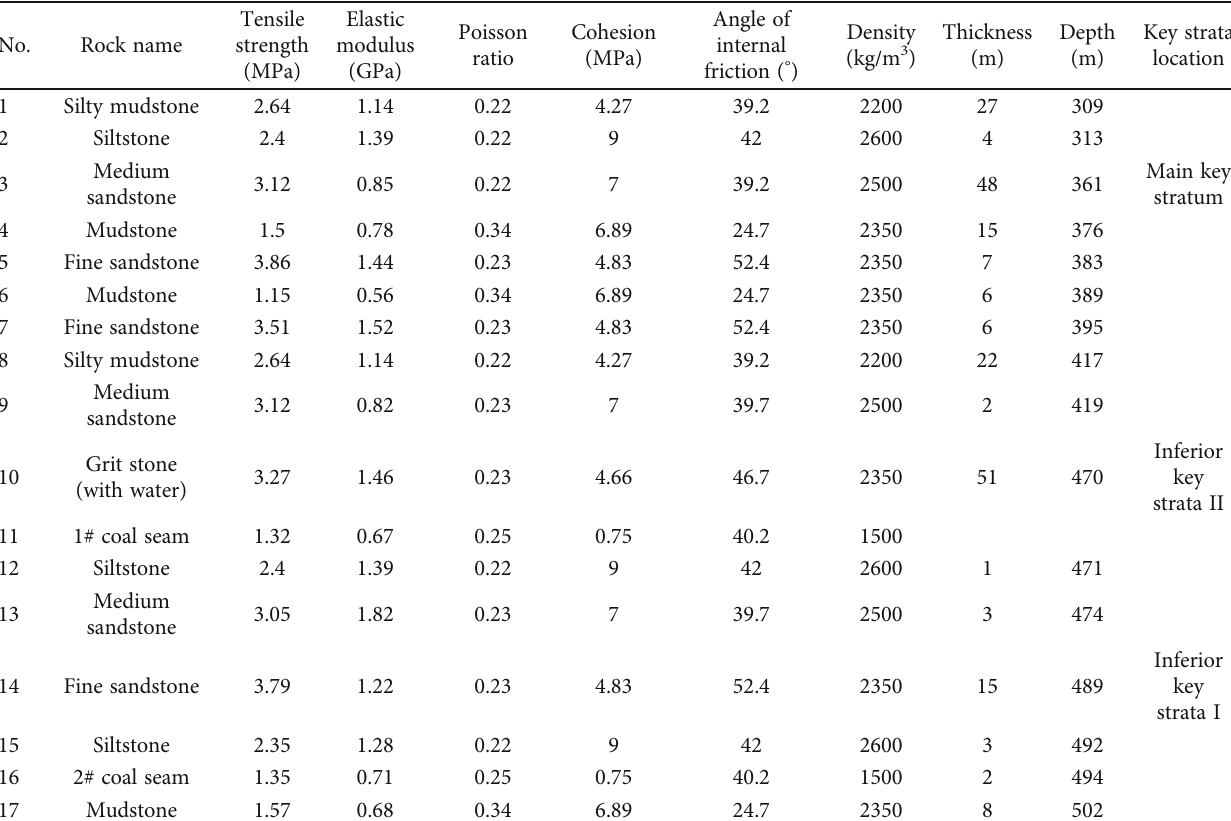
Table 1: Mechanical parameters of overlying rock of working face and identi fi cation of key horizon.